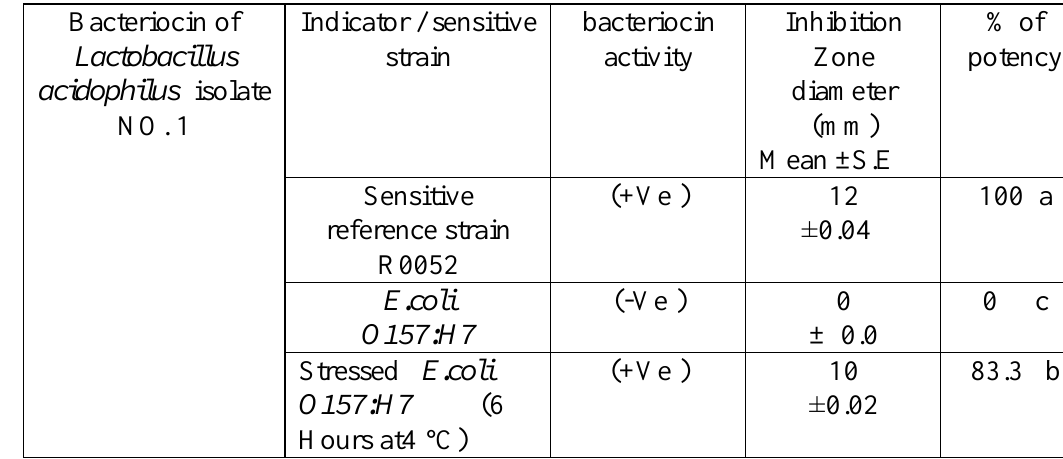
The antimicrobial spectrum of crude bacteriocin produced by L. acidophilus isolate NO. 1 against sensitive strain Lactobacillus acidophilus R0052 and